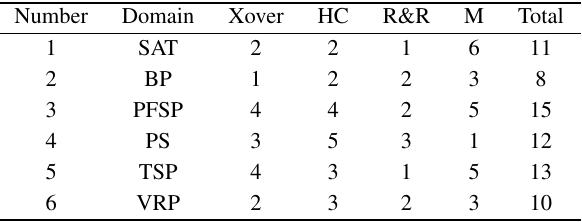
Table 1 Number of different types of low-level heuristic in different problem domains.